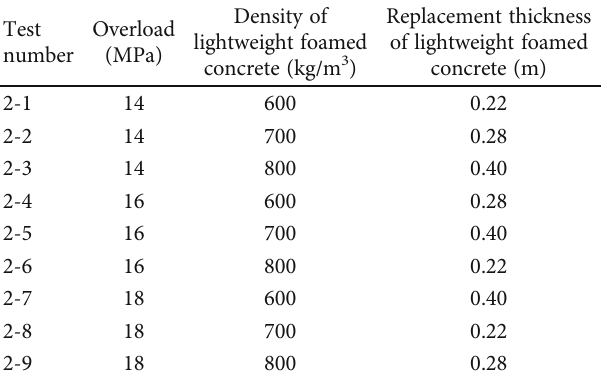
Table 2: The multiple-factor orthogonal test scheme.